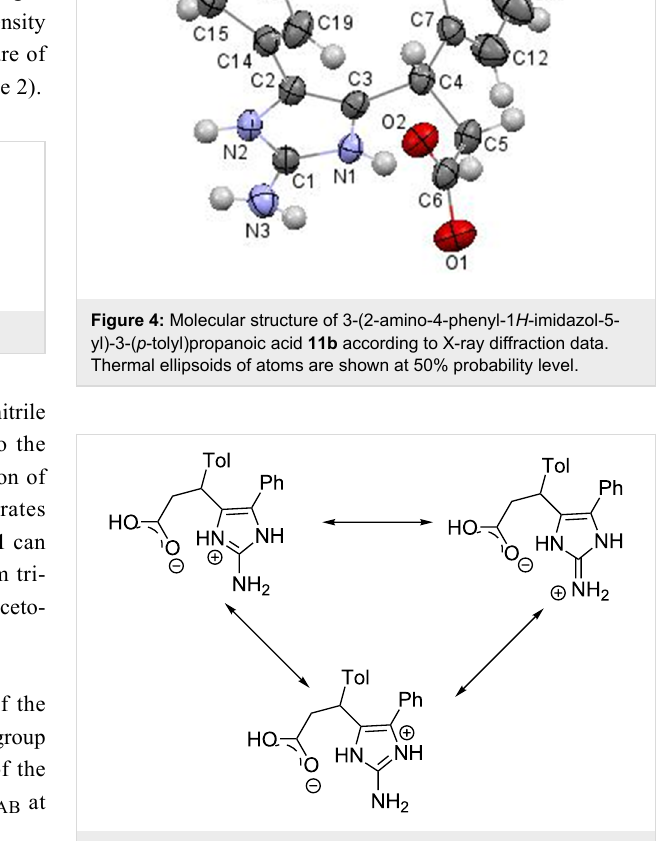
Scheme 3: Three forms of the compound 11b in the crystal